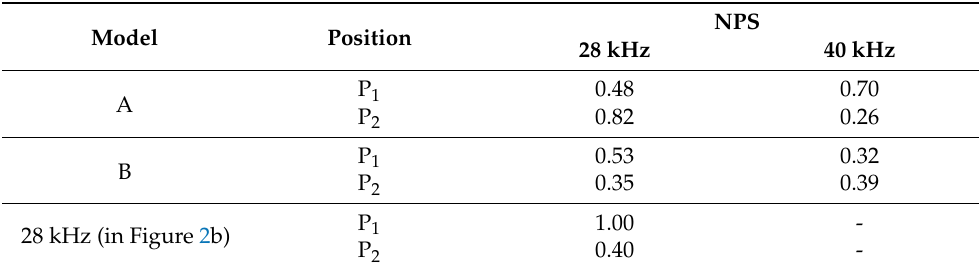
Table 2. Normalized power spectrum at positions P 1 and P 2 calculated by